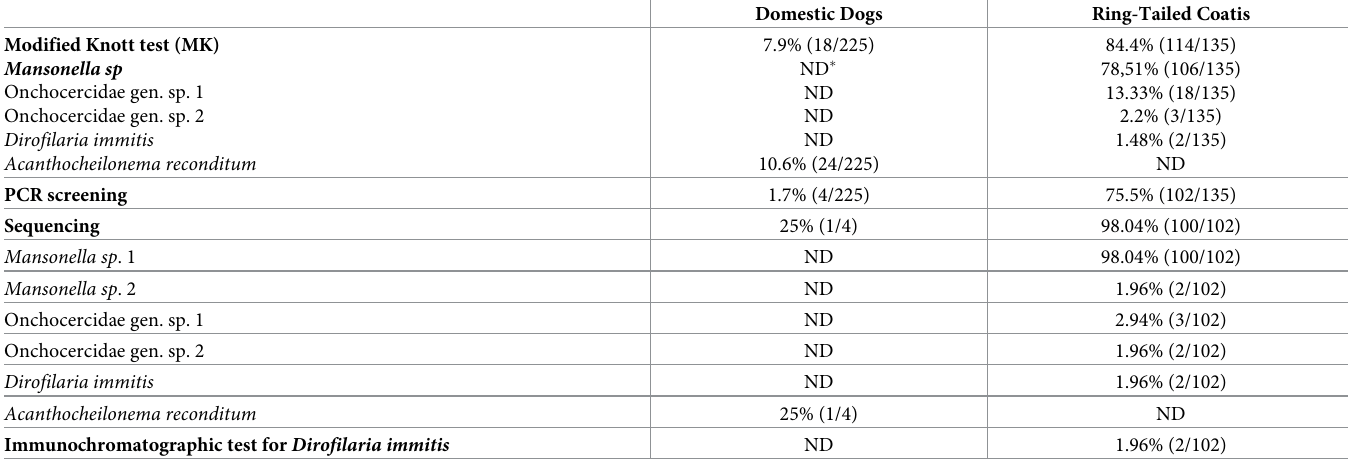
Table 3. Prevalence of Onchocercidae nematodes in ring-tailed coatis and domestic dogs from the Iguac¸u National Park, in relation to the diagnostic